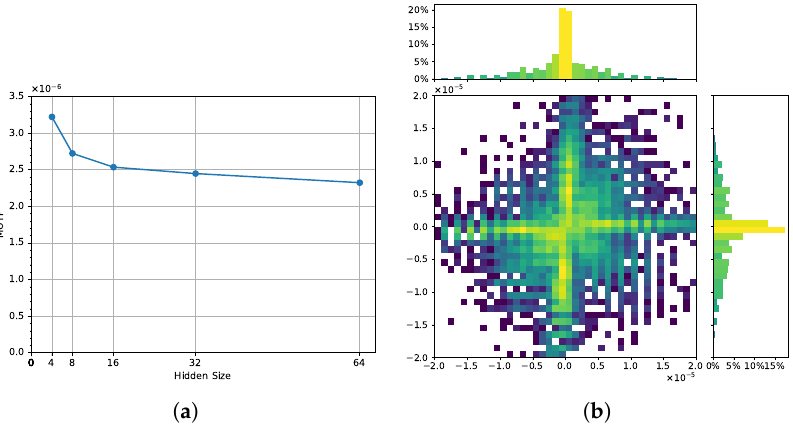
Figure 8. ( a ) The effect of hidden size on MOTP. ( b ) Distribution of longitude–latitude displacements. The data association algorithm, except for the RNN_LSTM, uses the proposed LSTM, and all other methods use the most commonly used online data association algorithm